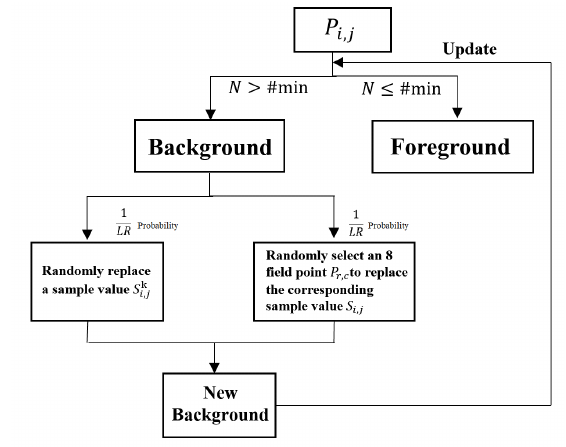
Figure 7. Update strategy between every two